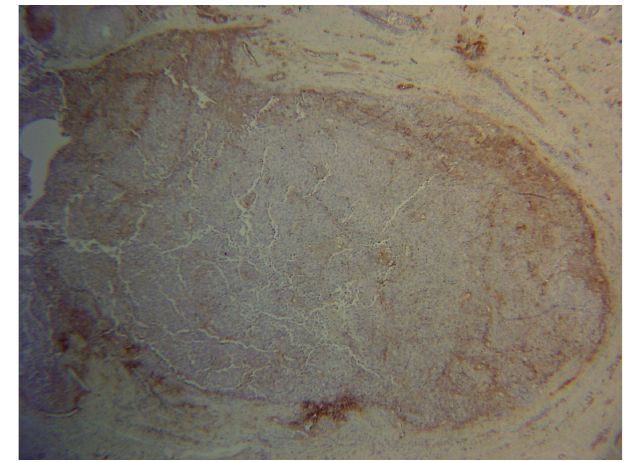
Figure 3. Nodule with laminin 5 staining